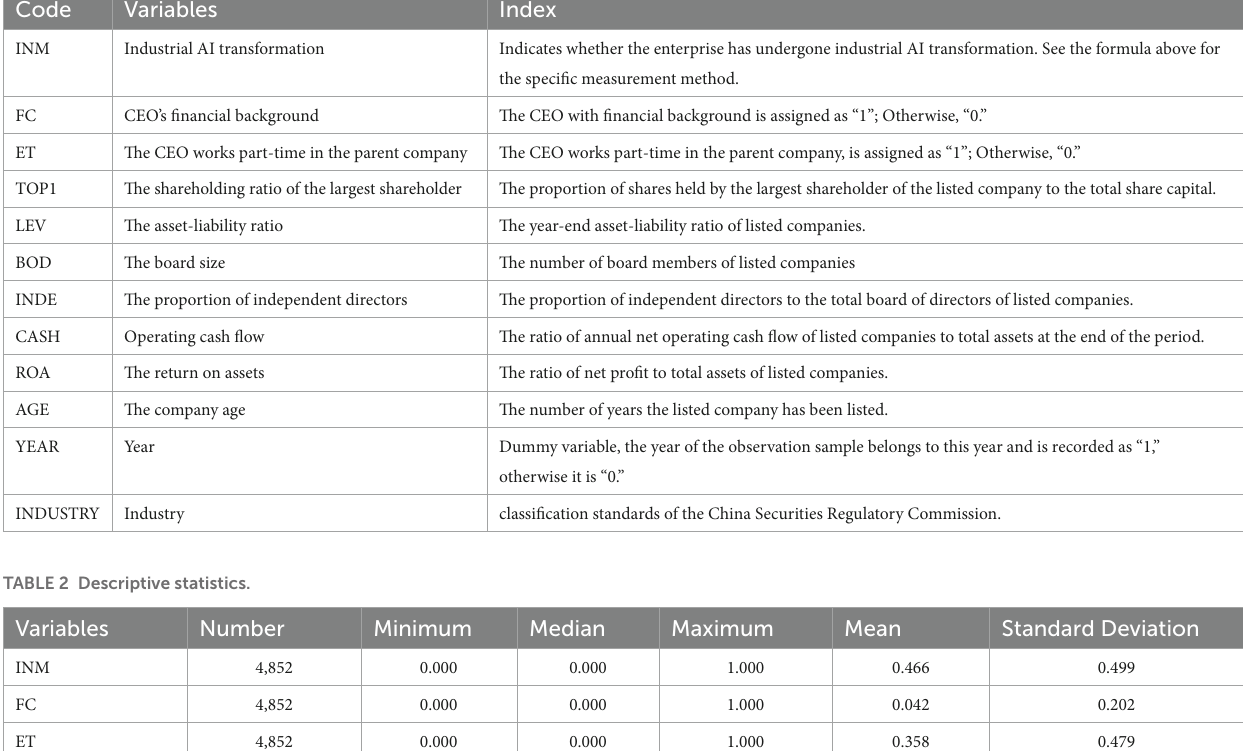
TABLE 1 Variable